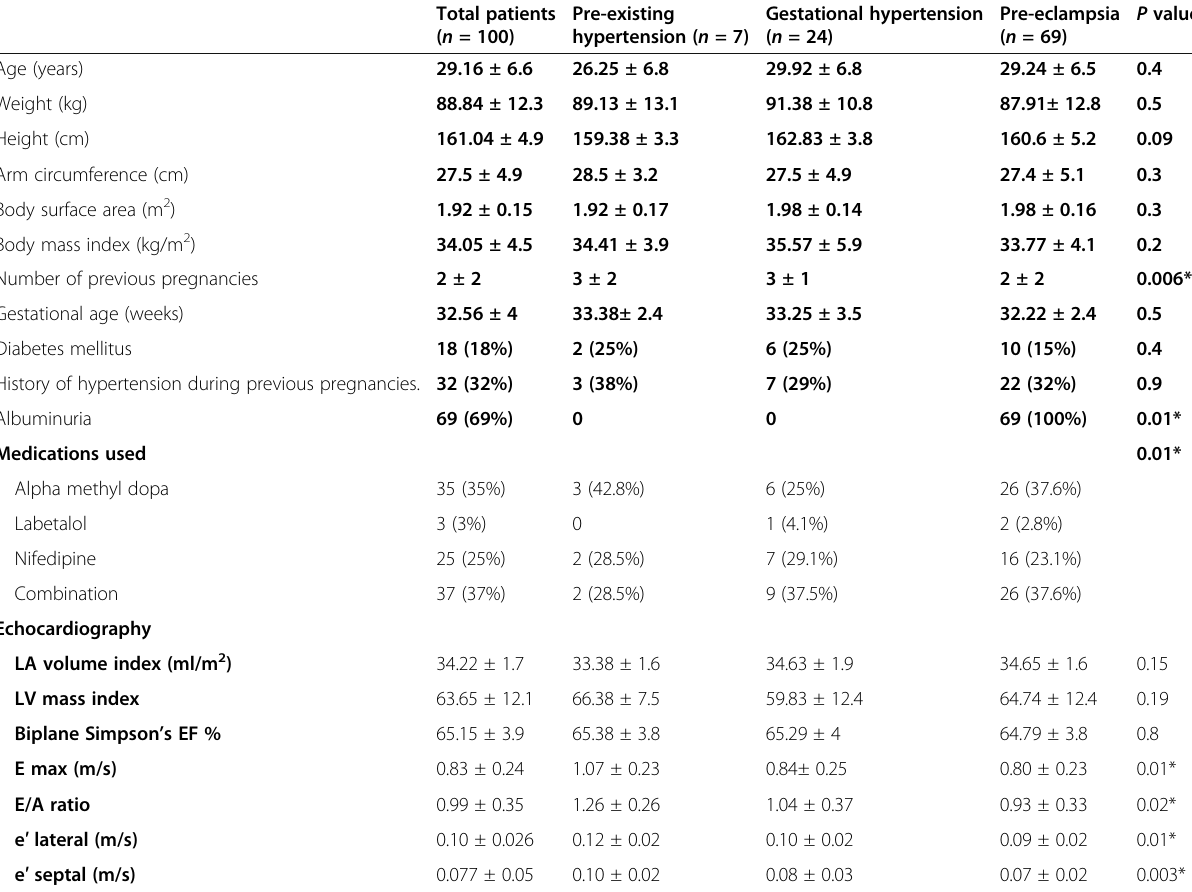
Table 1 Demographic, clinical and echocardiographic data of the study groups